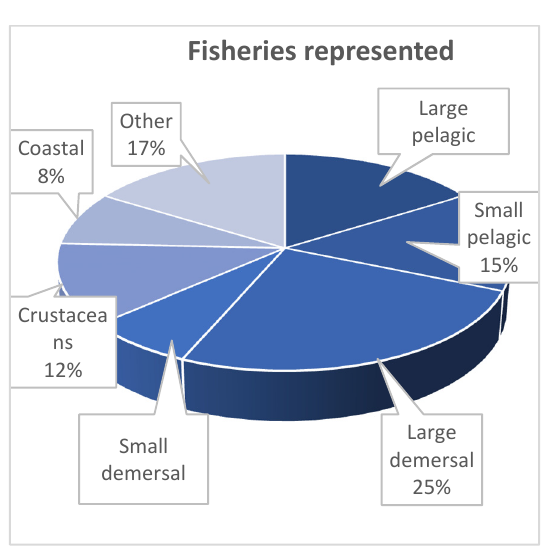
Figure 3. The fishery types covered by survey respondents. ‘Other’ includes shark, inland, aquaculture and shellfish (n = 143).